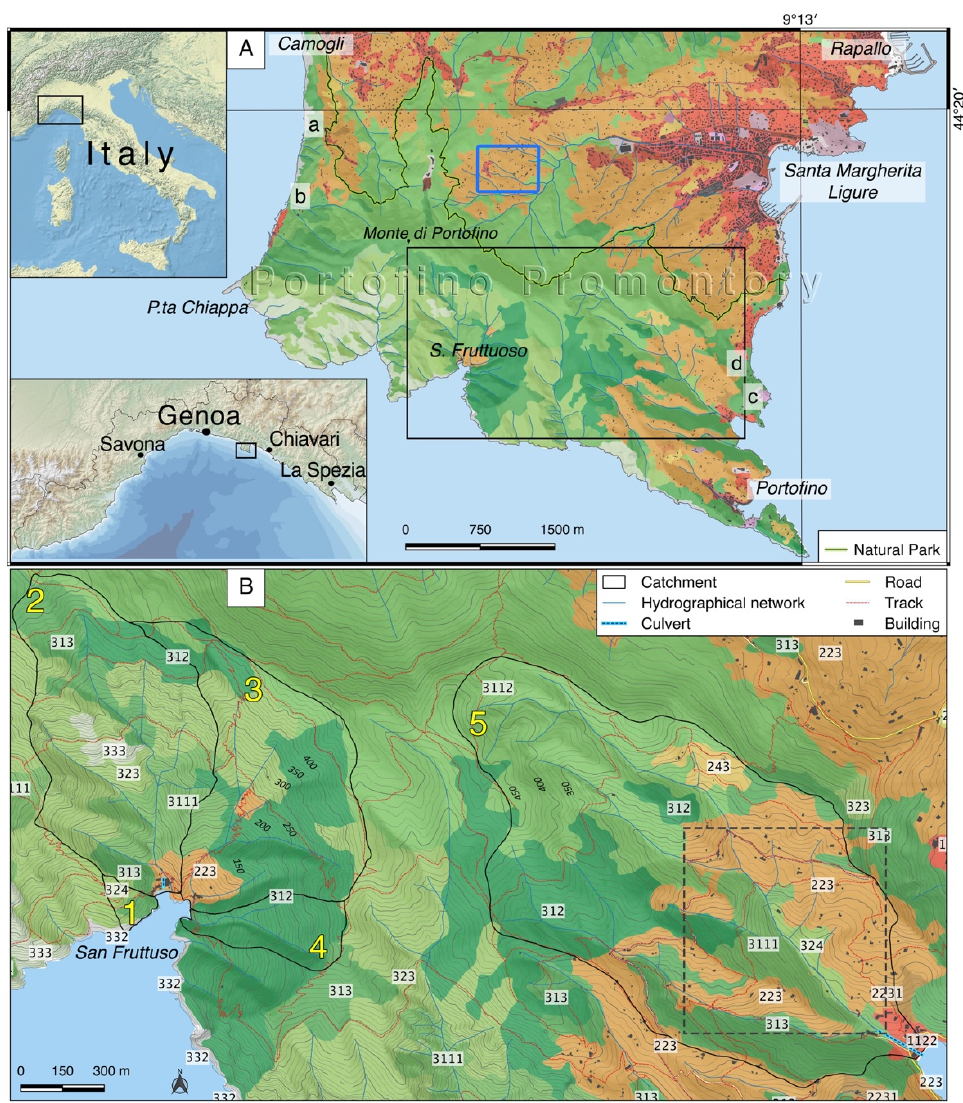
Figure 2. ( A ) Portofino promontory geographical sketch; dark blue box: stone wall bases detection test area (Figure 4); (a) San Rocco; (b) San Nicolò; (c) Cervara; (d) Le Gave. ( B ) The studied areas numbered 1 to 5 and Corine Land Cover 2018 tipology: 1122: Discontinuous built-up areas with family houses with gardens; 223: Olive groves; 2231: Abandoned Olive groves; 243: Agricultural areas; 3111: Broad-leaved forests with continuous canopy, not on mire; 312: Coniferous forests; 3112: Broad-leaved forests with continuous canopy on mire; 313: Mixed forests; 323: Sclerophyllous vegetation;